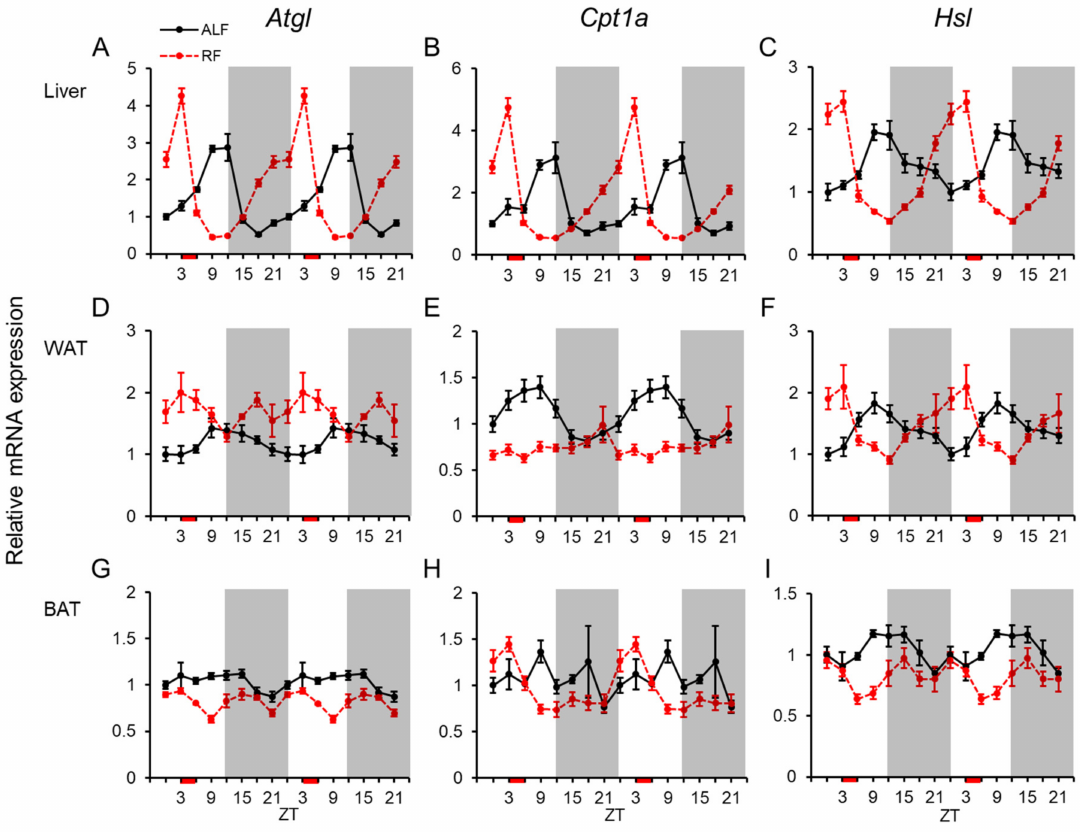
Figure 5. mRNA expression levels of lipolytic genes in the peripheral tissues. Double-plotted graphs showing the mRNA expression levels of the adipose triglyceride lipase ( Atgl ), carnitine palmitoyl transferase 1a ( Cpt1a ), and hormone-sensitive lipase ( Hsl ) genes in the liver ( A – C ), white adipose tissue (WAT: D – F ), and brown adipose tissue (BAT: G – I ) under ad libitum feeding (ALF: Black lines) and time-restricted feeding (RF: Red lines) schedules. Data are expressed as the mean ± standard error of the mean, n = 5–6 mice per datum